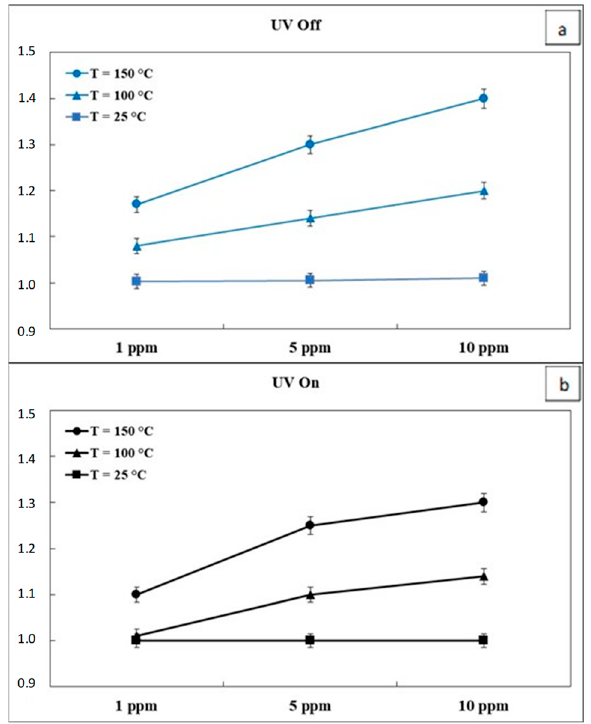
Figure 6. In 2 O 3 sensor response at di ff erent CO concentrations and temperatures in “UV O ff ” ( a ) and “UV On” ( b ) mode. Error bars are calculated on the average of 5